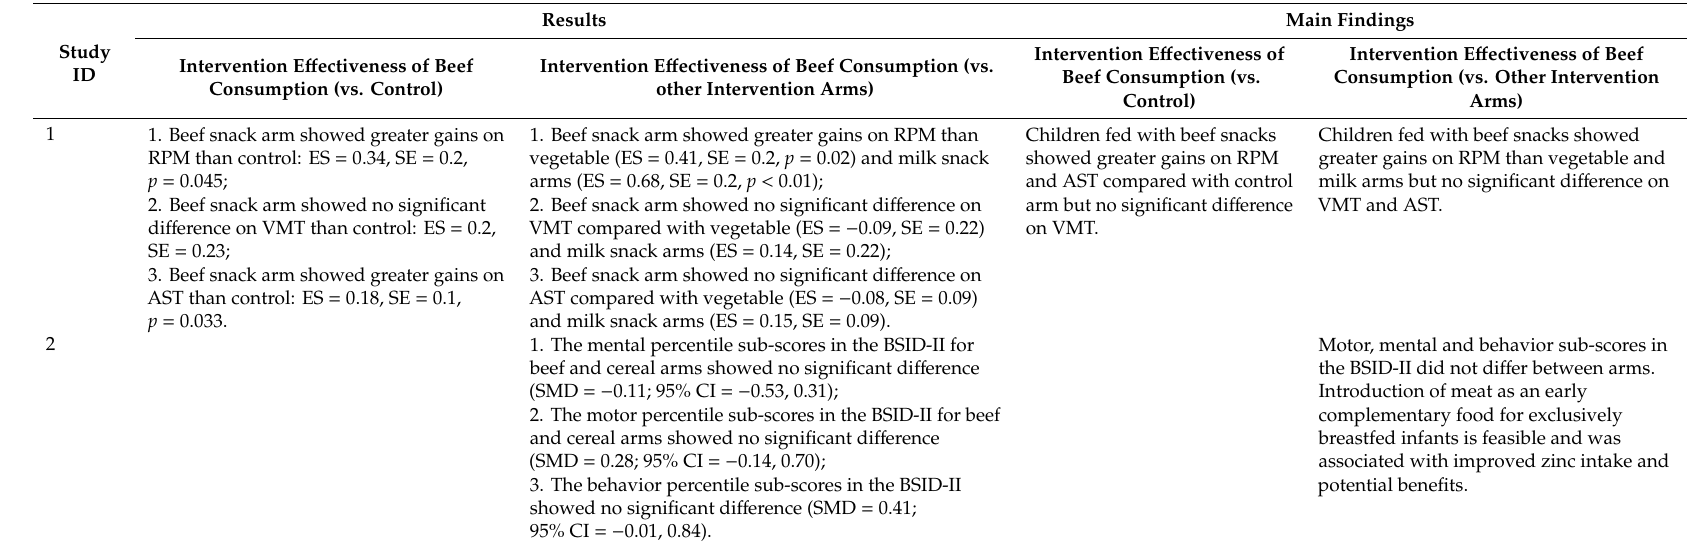
Table 3. E ff ect estimates and main findings on beef consumption and